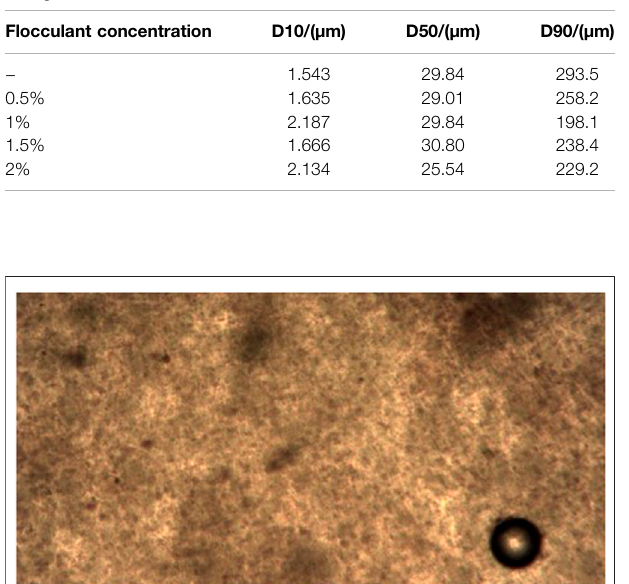
TABLE 8 | Effect of CaCl 2 concentration on particle size distribution of PEM drilling fl uid.